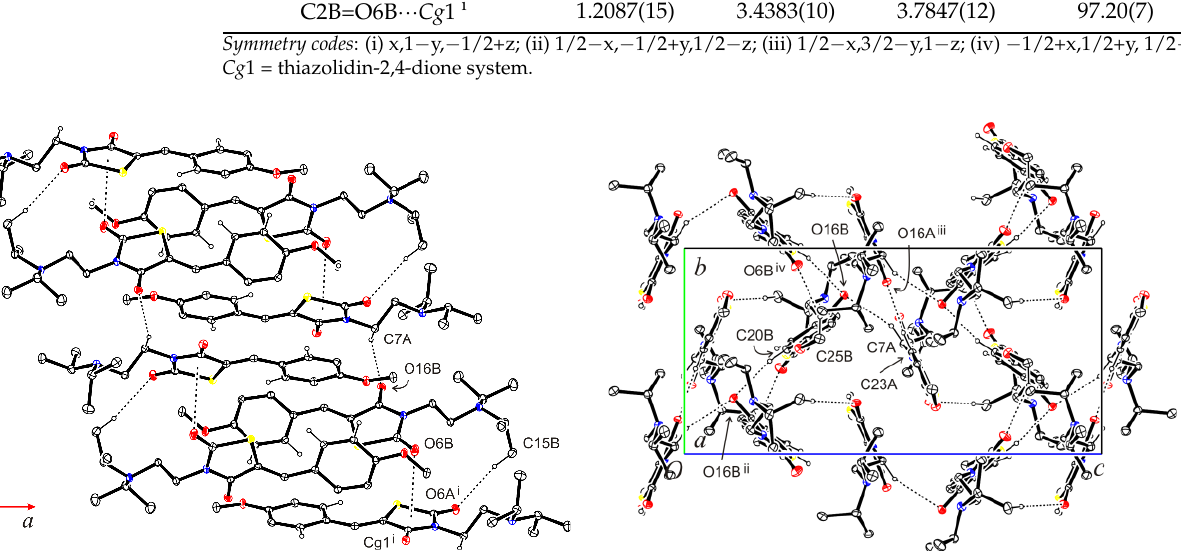
Figure 4. The C –H∙∙∙O hydrogen bonding and C=O∙∙∙ Cg 1 intermolecular interactions in the crystal structure of 3 . The H atoms not involved in hydrogen bonds have been omitted for clarity; Cg 1 = thiazolidin-2,4-dione system. Table 1. Hydrogen bonds and Y- X∙∙∙ Cg interactions in the crystal structure of 3 .